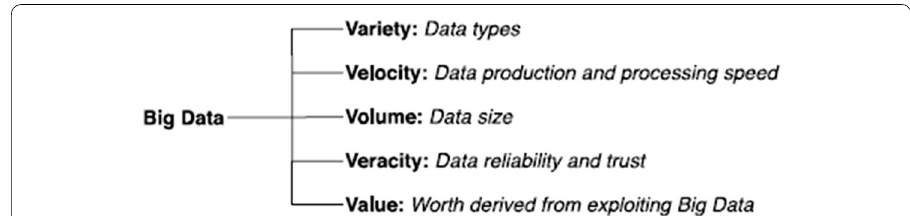
Fig. 3 The V’s of big data (Source: Adapted from the